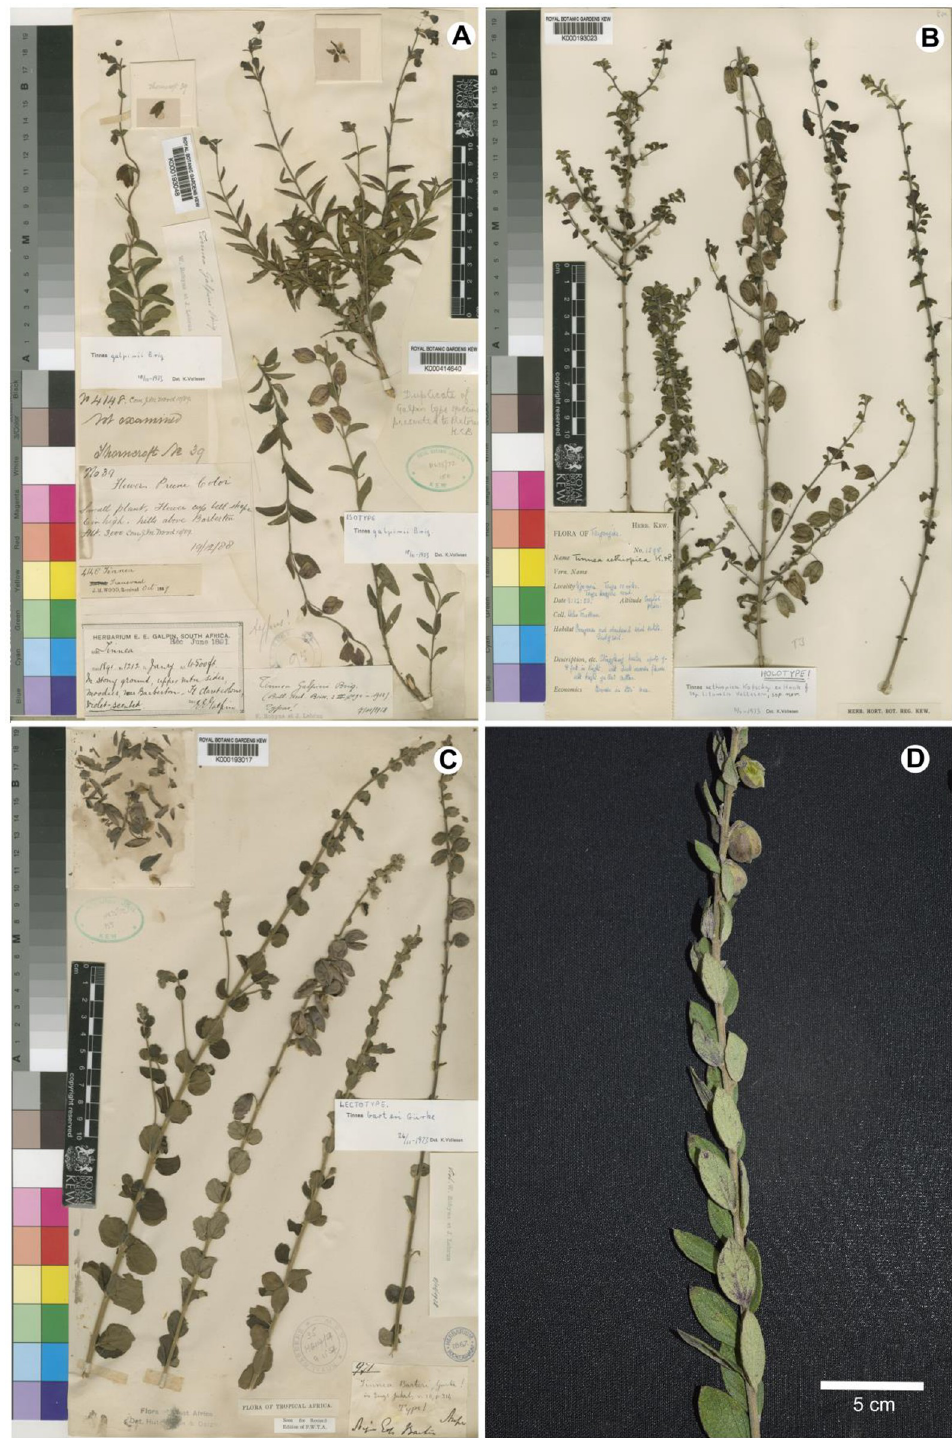
Fig 4. Scanned type herbarium specimens of the most similar Tinnea species. (A) T . galpini ; (B) T . aethiopica; (C) T . barteri ; and (D) T . gombea to show the similarities and variations in morphological characters. Copyright: the Board of Trustees of the Royal Botanic Gardens, Kew, United Kingdom. Reproduced with the consent of the Royal Botanic Gardens, Kew